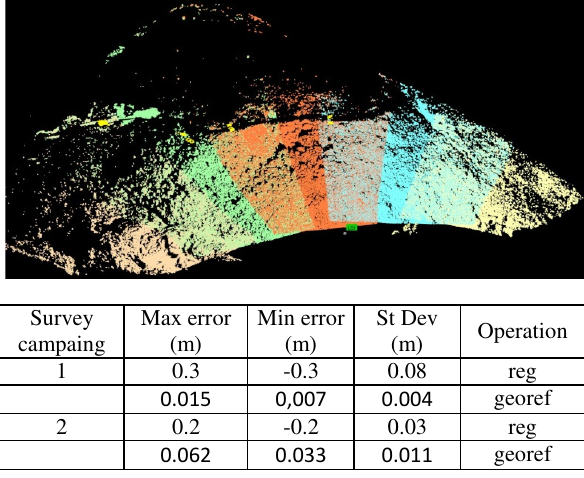
Figure 7. A s ingle point cloud acquired with Optech